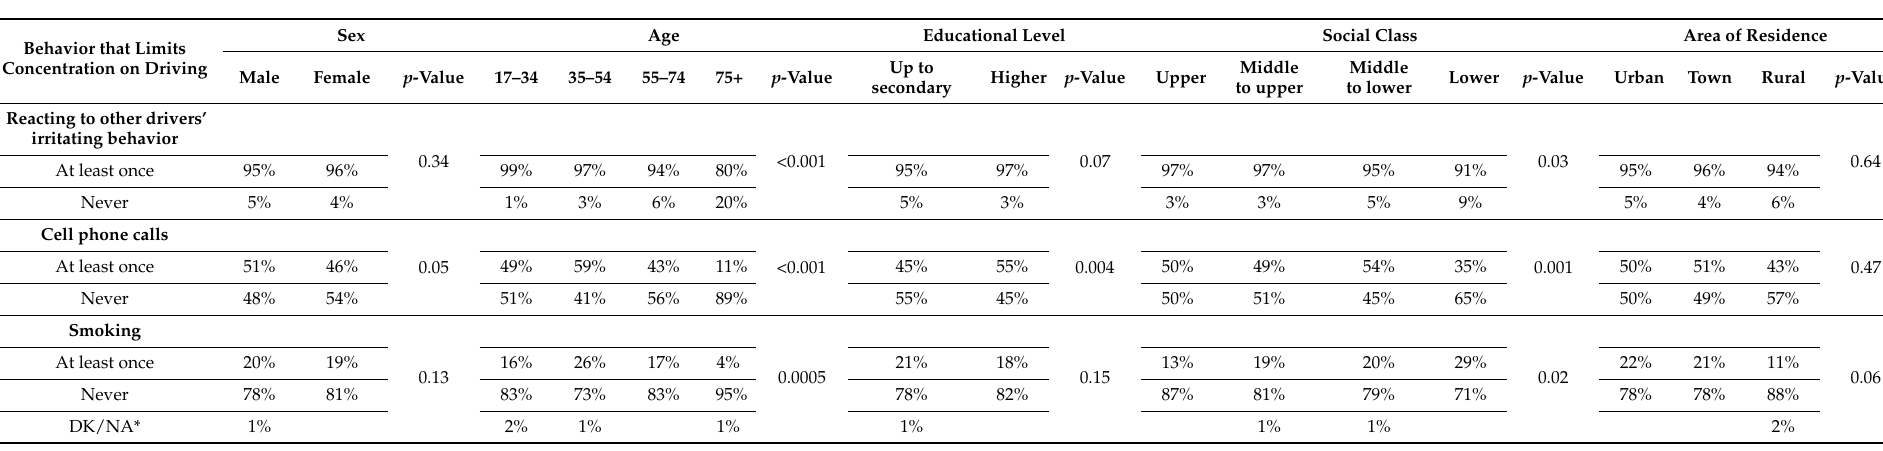
Table 6. Behavior that limits concentration by demographic characteristics of participants (questions were structured as “how many times in the past three months have you . . .